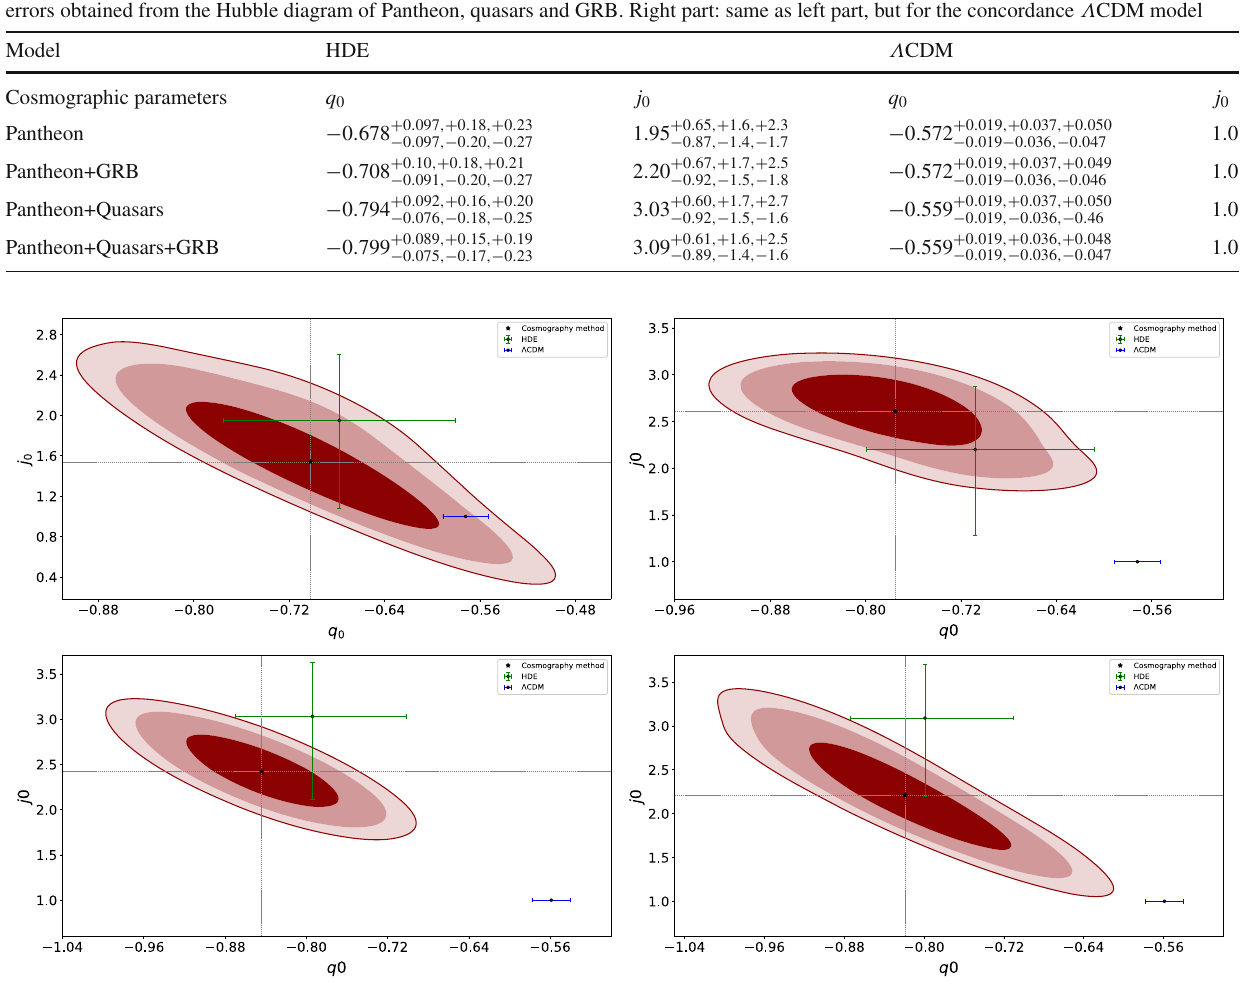
Fig. 2 The1 − σ ,2 − σ and3 − σ confidenceregionsforthedeceleration parameter q 0 and the jerk parameter j 0 obtained from the cosmography method. Also, the best-fit values of q 0 and j 0 with 1 − σ error have been shown for the HDE and Λ CDM cosmologies. The upper-left (upper-